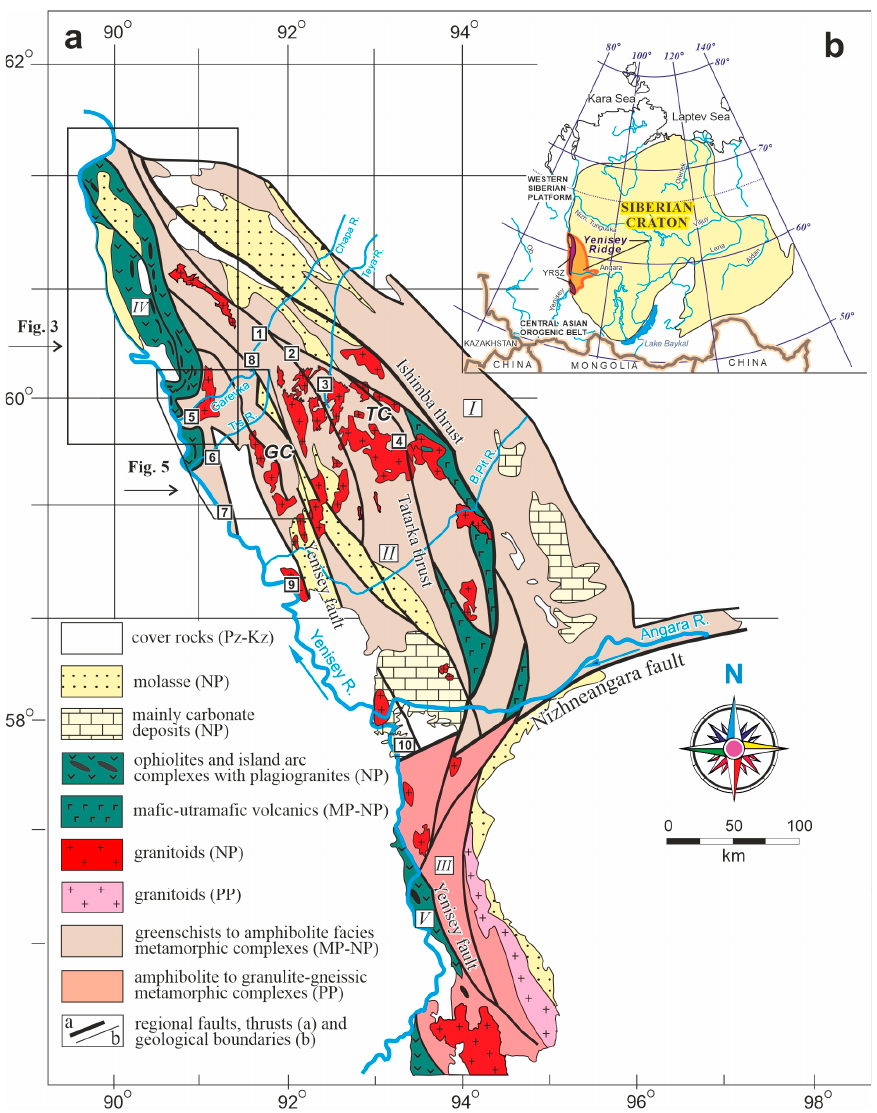
Figure 1. ( a ) Geological sketch map of the Yenisey Ridge showing the location of the study areas